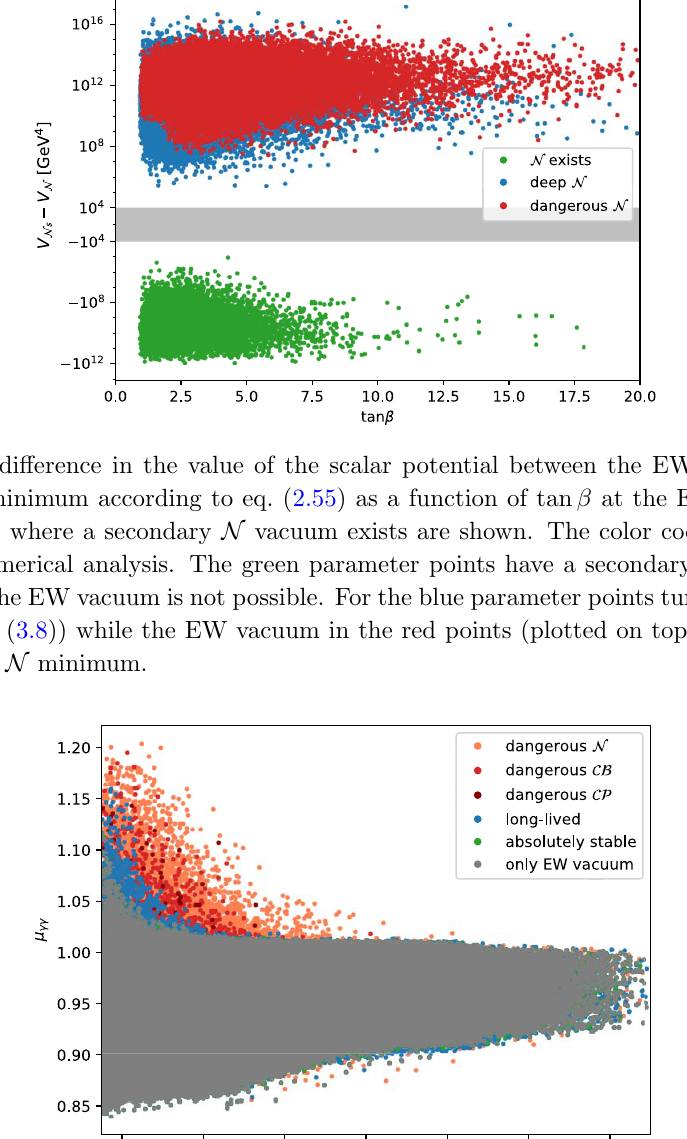
Figure 3 . The signal strength µ of h 125 γγ as a function of the charged Higgs mass. The pa- γγ → rameter points without any secondary minima (grey) are plotted on top, followed by the absolutely stable (green), and long-lived (blue) parameter points. Below these, the points with dangerous secondary minima are shown in different shades of red denoting the type of dangerous minimum present ( — light red, — red, — dark N CB CP